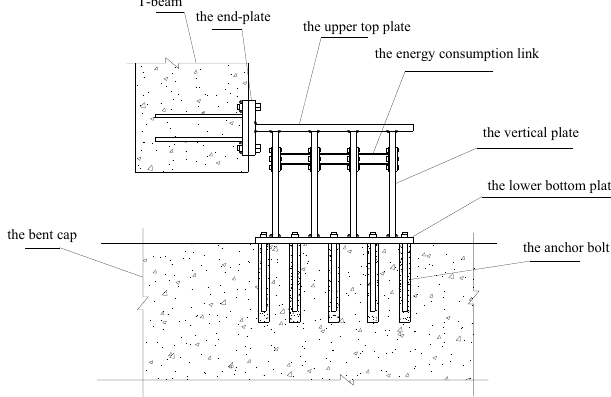
Figure 1. The new alternative retainer.